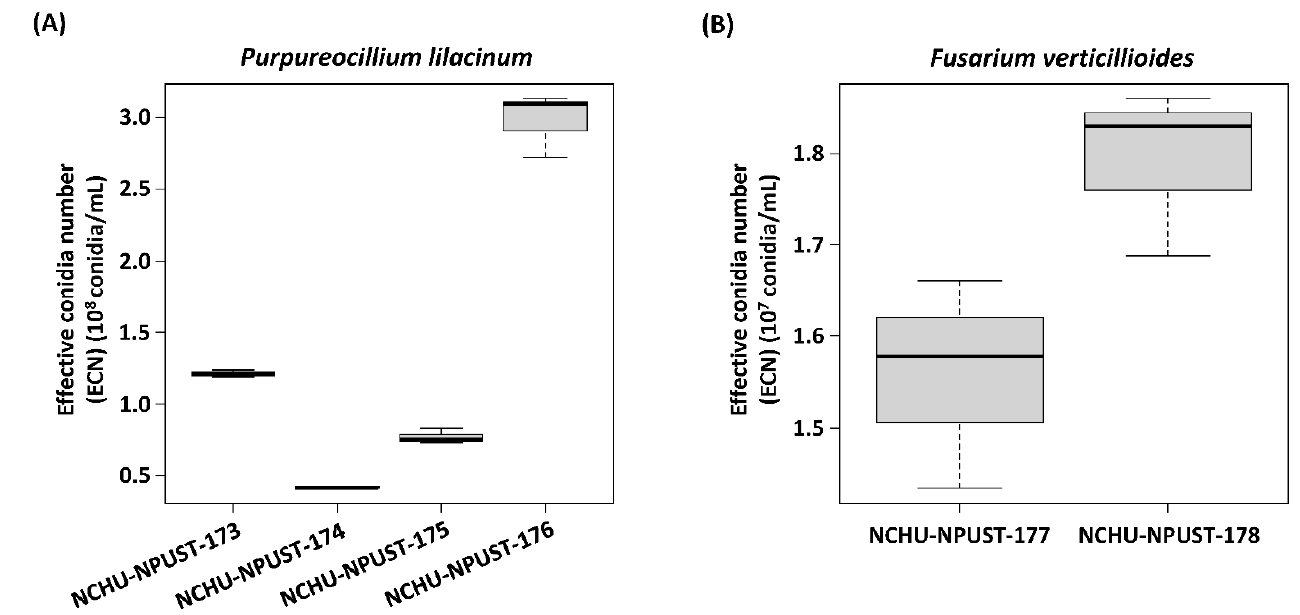
Figure 2. The effective conidia numbers (ECNs) of six fungal isolates. ( A ) P. lilacinum PL-NCHU- NPUST-173 to -176; ( B ) F. verticillioides FV-NCHU-NPUST-177 and -178.